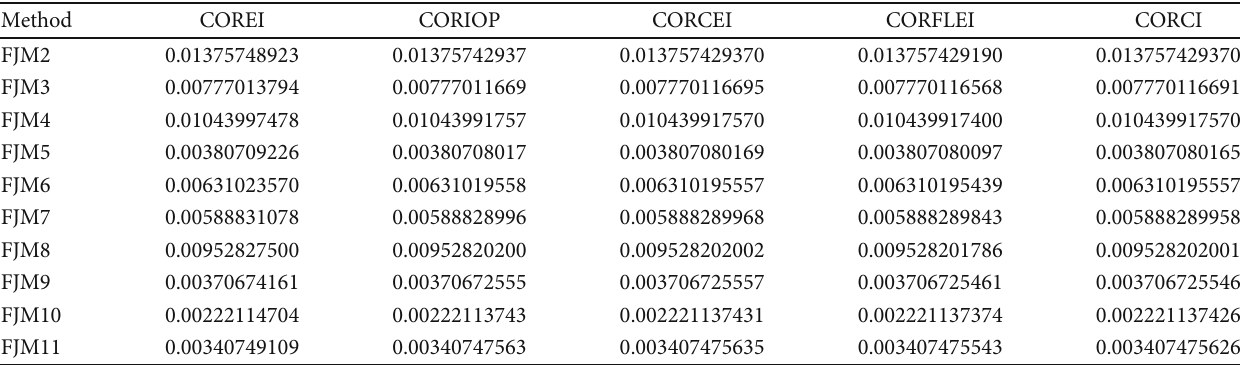
Table 38: Values of corrected e ffi ciency indices for the methods in the third category to solve Test Problem 1, and n = 500 .